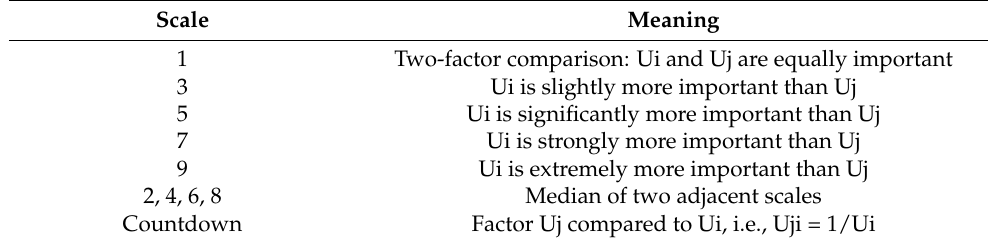
Table 1. Hierarchical analysis 1–9 digital scale. Scale Meaning 1 Two-factor comparison: Ui and Uj are equally important